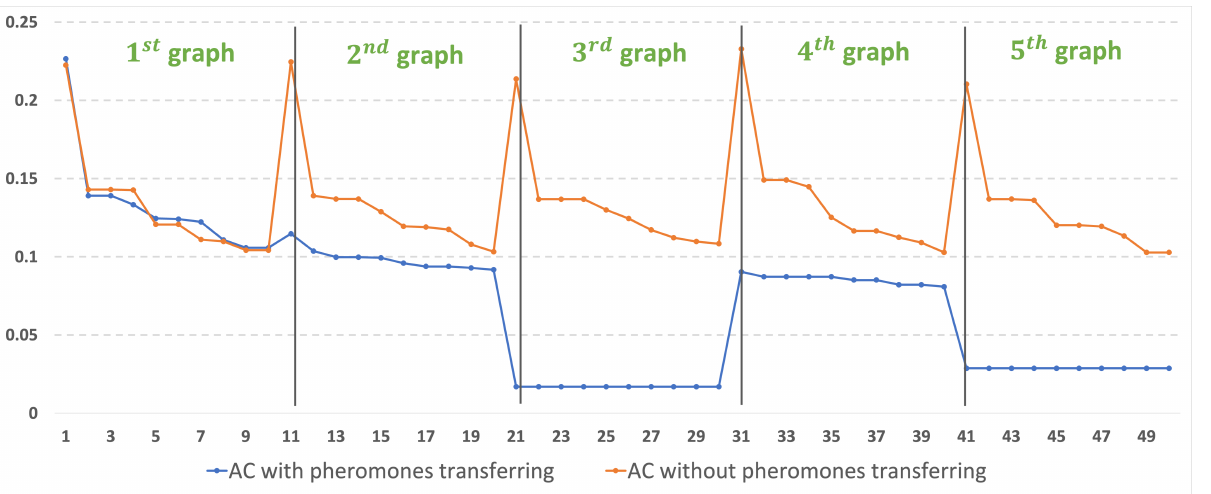
Figure 10. AC for low-cost continuous bounded degree spanning tree algorithm for an 800-vertex graph.